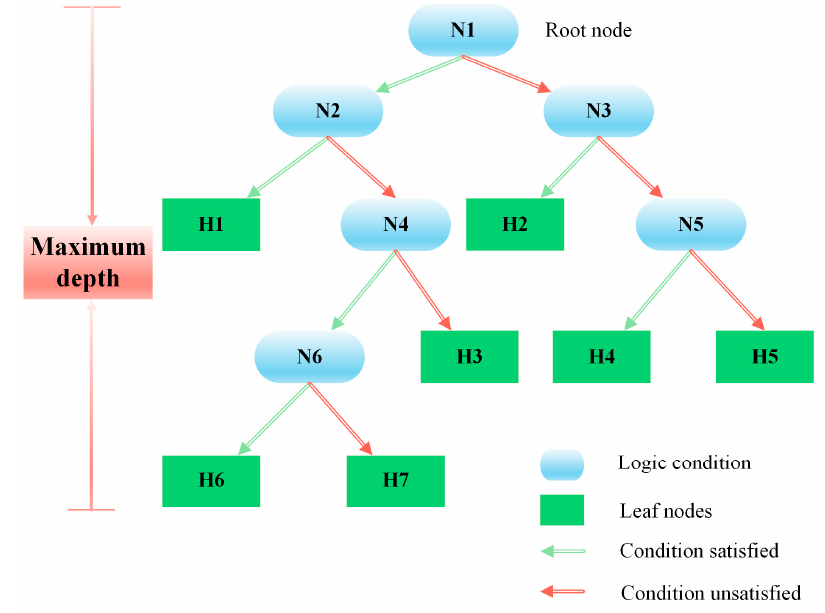
Figure 4. A typical DT structure.